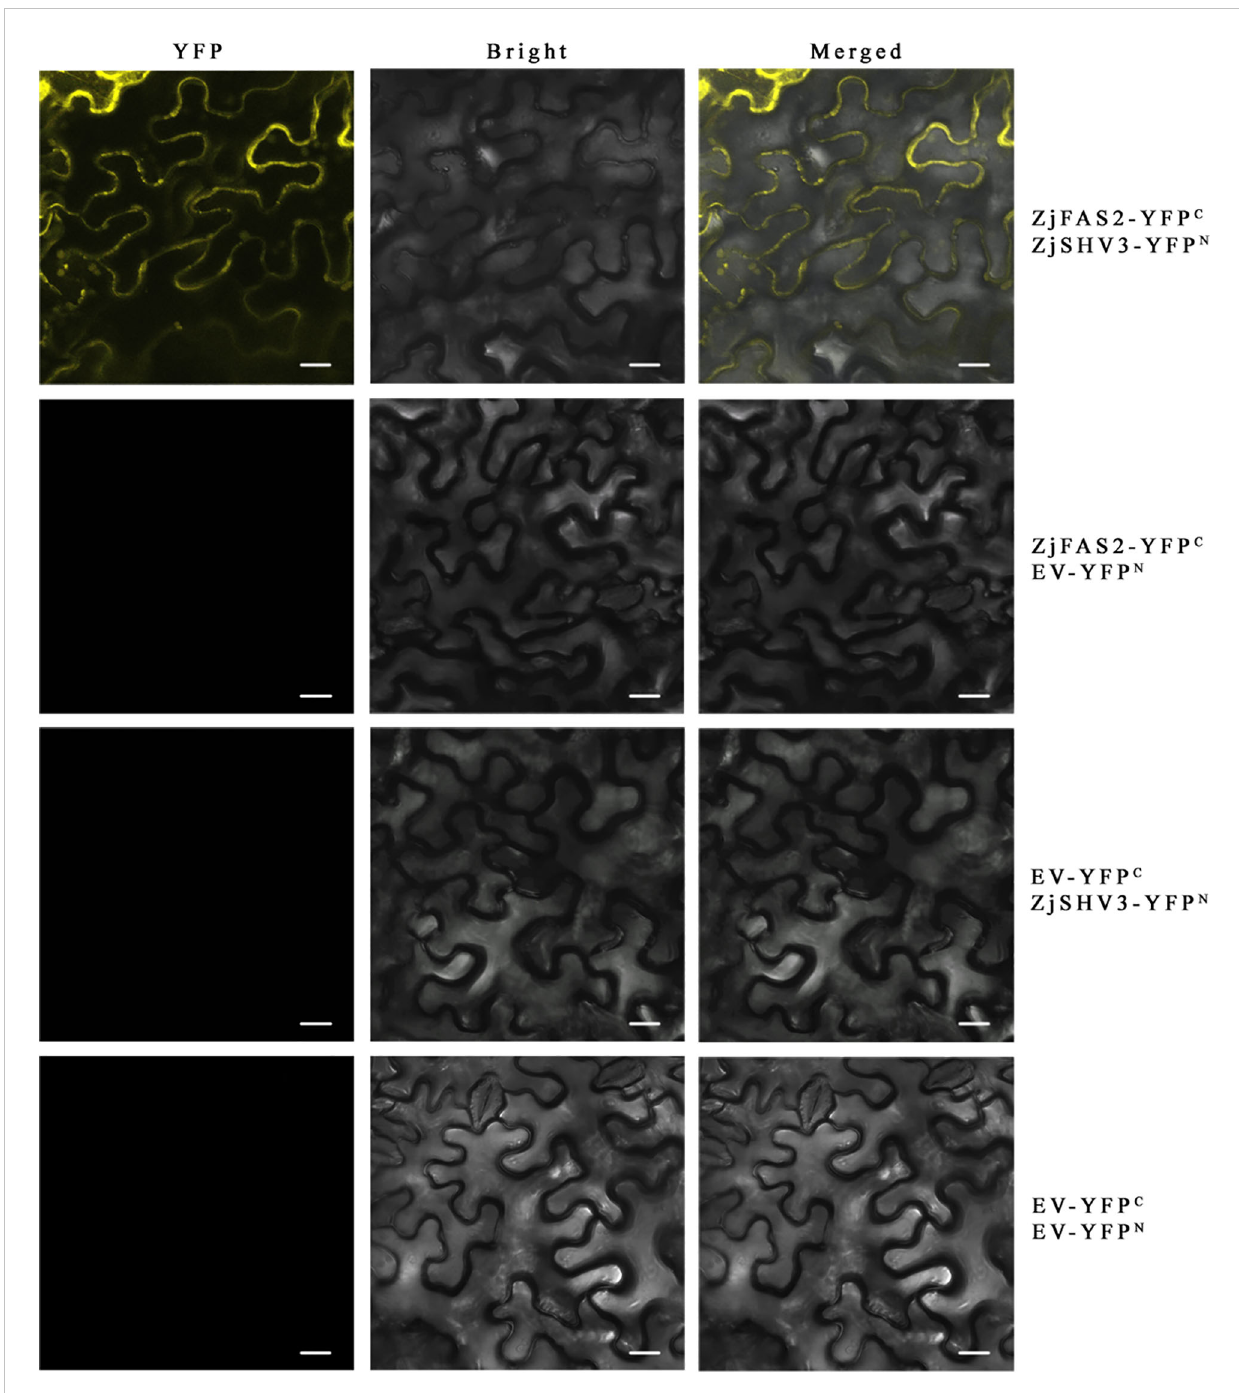
FIGURE 8 BiFC assay veri fi es the interaction between ZjFAS2 and ZjSHV3 in the tobacco leaves. Bars = 20 m